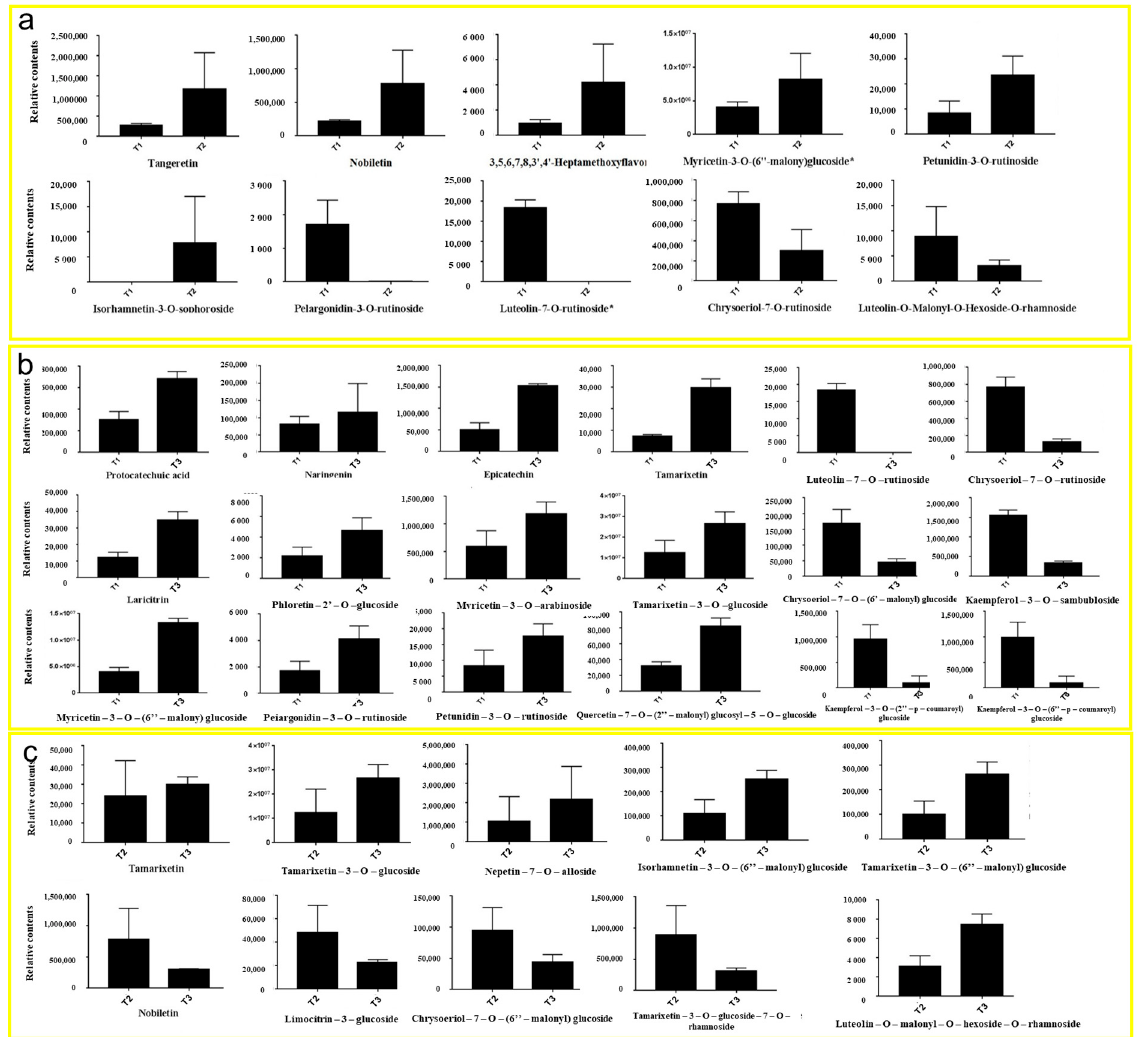
Figure 5. Relative contents of flavonoid and anthocyanin metabolites in HSK at different flowering stages: the bud stage ( a ), full flowering ( b ), and falling flower stage ( c ).